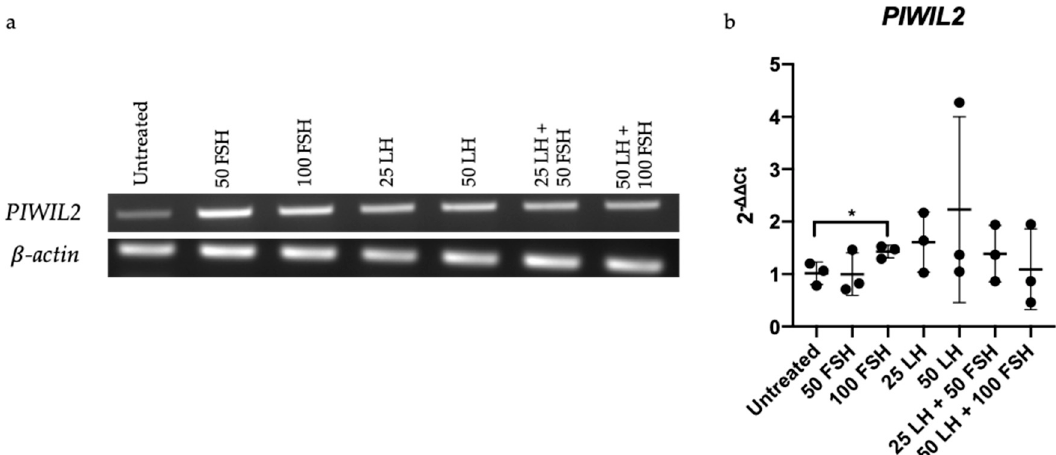
Figure 5. PIWIL2 expression in OV-90 cells before and after a 24-h follicle stimulating hormone (FSH) and luteinizing hormone (LH) treatment. ( a ) RT-PCR: PIWIL2 expression increased upon individual and combination treatment of FSH and LH. ( b ) qRT-PCR: PIWIL2 had a significant increase in expression after 100 mIU/mL FSH treatment. Ct scores were normalized to housekeeper, HPRT1 and the average of untreated cells for 2 − ∆∆ CT . Each colored circle represents one biological replicate with technical duplicate where three biological replicates were carried out per treatment group. Labels with numerical values indicate concentration (mIU/mL) of hormone used. Mean with standard deviation was plotted. Unpaired t -test was used to assess significance. * p < 0.05.